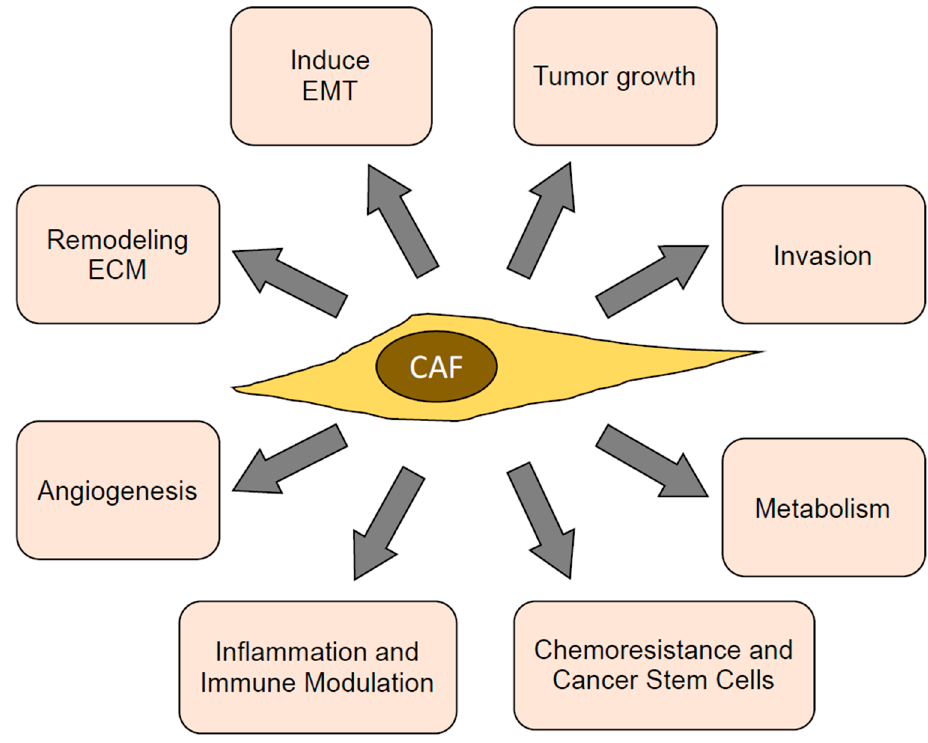
Figure 2. Functions of CAFs contributing towards tumor progression. ECM: extra cellular matrix; EMT: epithelial–mesenchymal transition. Table 1. Functional roles of cancer associated fibroblasts (CAFs) in tumor progression. No.